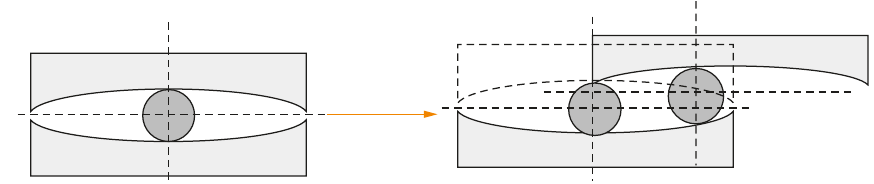
Figure 3: Isolation device of cosine rail